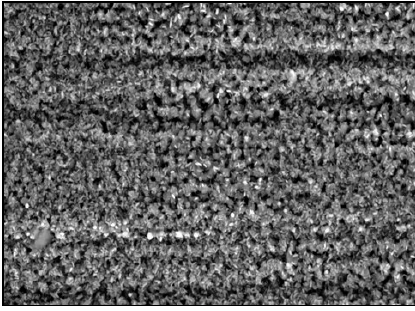
Figure 14. Top-down SEM image of Inconel 625 sample surface after 100 h heating (5000×).